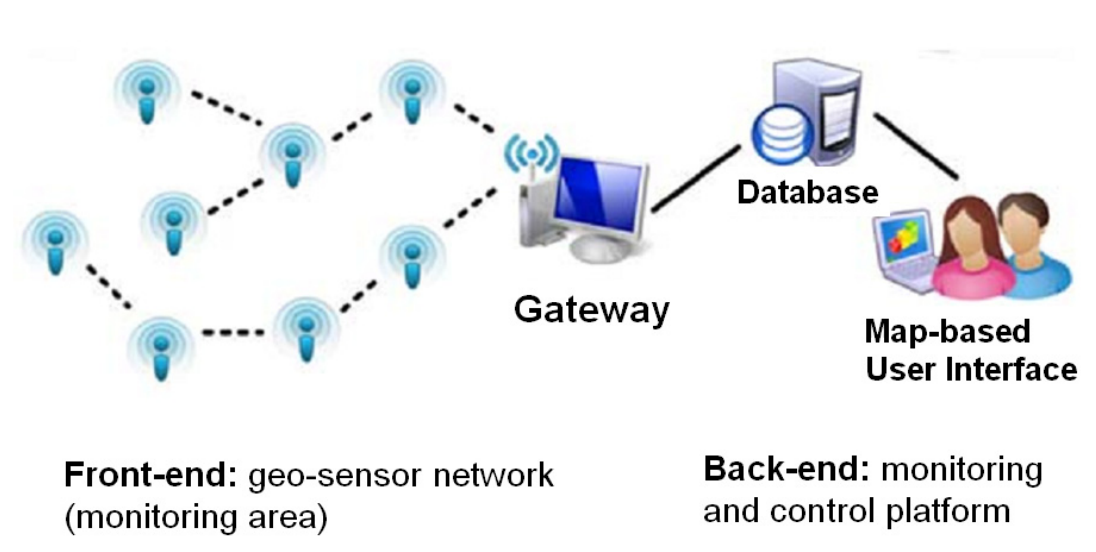
Figure 1. System overview: The wireless sensor network comprises two major components: ( 1 ) front-end: geo-sensor network and ( 2 ) back-end: monitoring and control platform. The sensor network is responsible for measuring the concentration of air pollutants in the study area. The monitoring and control platform receives monitoring data through a map-based system to provide real-time information of the sensor data. The data gateway nodes connect the front end and back end by wireless